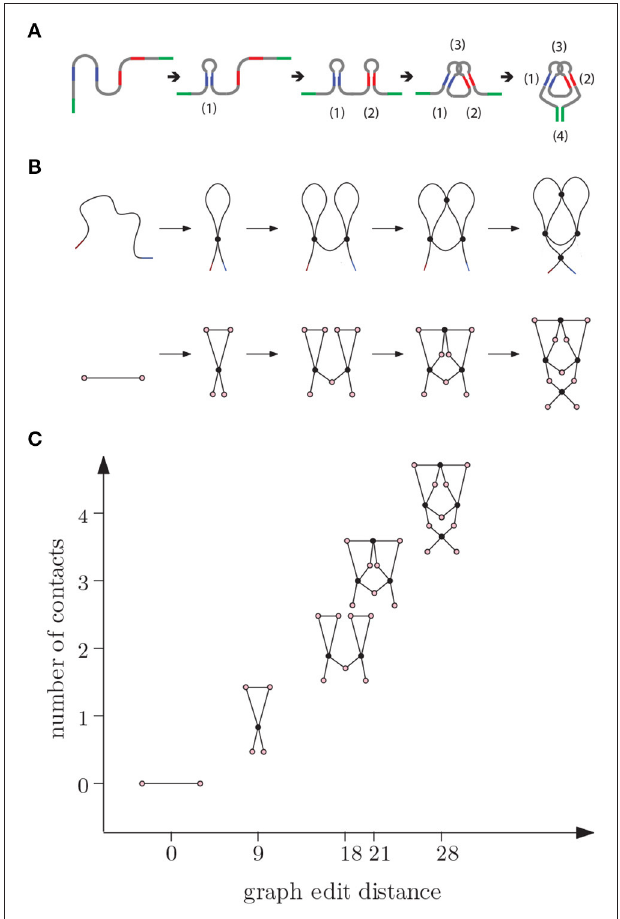
FIGURE 7 | (A) E adenine riboswitch folding. Four intramolecular contacts are formed during folding as indicated in the figure [ 53]. (B) Coarse grained representation of the folding process. (C) We can represent folding in a graph where the x -axis (reaction coordinate) is the graph edit distance from the original molecule to the molecular strand with no contacts and y -axis is the number of contacts.